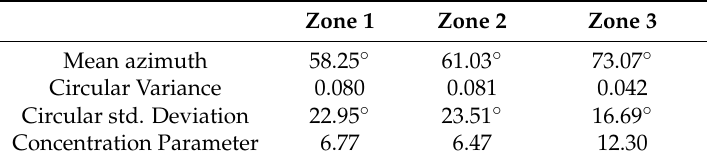
Table 4. Circular statistics for the values of the slopes for the three zones.